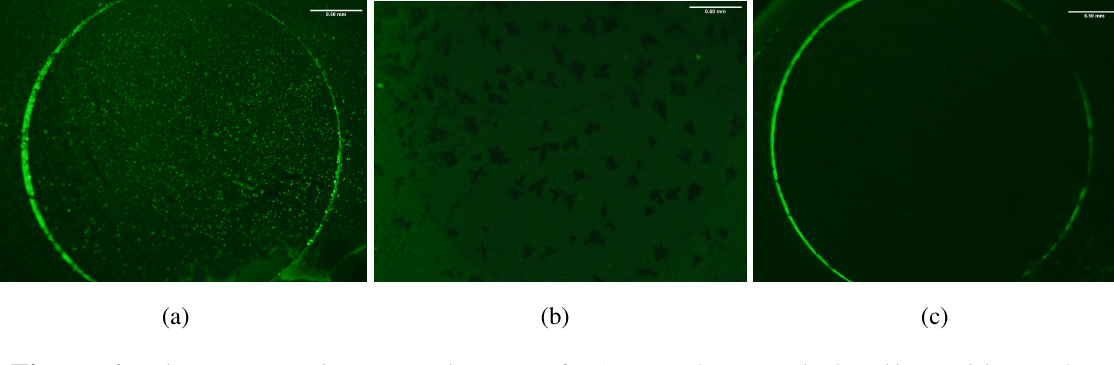
Figure 6. Fluorescent microscopy images of ( a ) Bound magnetic bead/ E. coli /secondary bead complexes on RGO-GCE; ( b ) negative control 1 (DI water as starting sample- no E. coli present); and ( c ) negative control 2 (polyGs absent on the magnetic bead/ E. coli /secondary bead